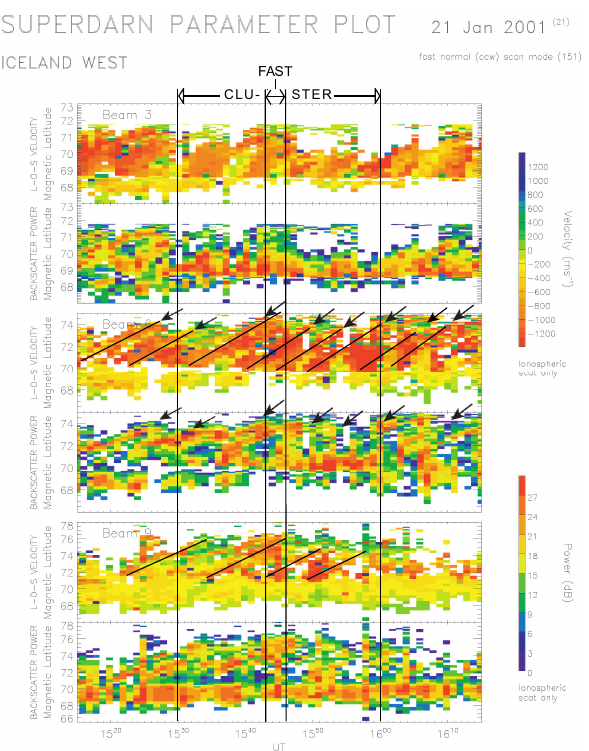
Fig. 12. Returns (l-o-s Doppler - shifted velocities and backscatter power) from beams 3, 6, and 9 of the CUTLASS/SuperDARN radar station Iceland West. The outer vertical guidelines indicate the con- junction with Cluster, while the inner, that with FAST. On beam 6 we have shown by arrows the flow bursts moving poleward, also marked by slanted lines. Flows of around 1000m/s −− 1 and higher are